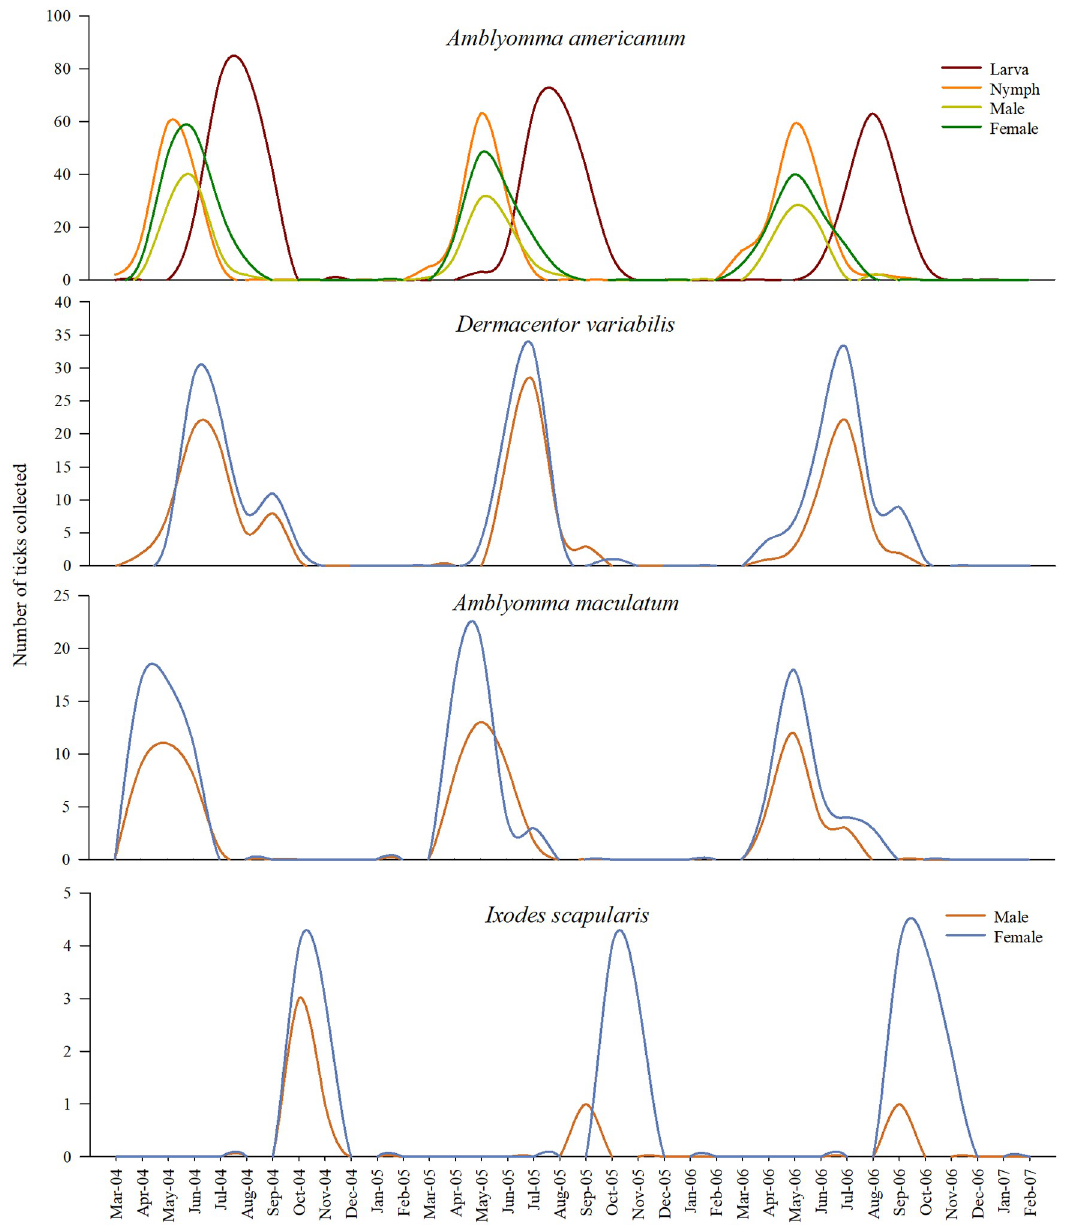
Fig 6. Tick phenology observed in mixed vegetation near Pittsburg, Kansas between years 2014–2017. Lines represent total number of individual specimens collected at monthly intervals and are not smoothed estimates. https://doi.org/10.1371/journal.pone.0250272.g006 activity of D . variabilis increased in July, and the questing activity of adult A . maculatum occurred earliest in the year among all three ticks, in May, in all the sites. Male ticks of D . var- iabilis and A . maculatum that were collected from woodland vegetation quested in high num- bers earlier than their female counterparts (Fig 4). Early emergence of male ticks was not observed among A . americanum ticks in any of the three vegetation types, and unlike the trend in woodland vegetation, the peak activity period for the adults of D . variabilis and A . macula- tum in grassland (Fig 5) and mixed vegetations (Fig 6) occurred simultaneously.